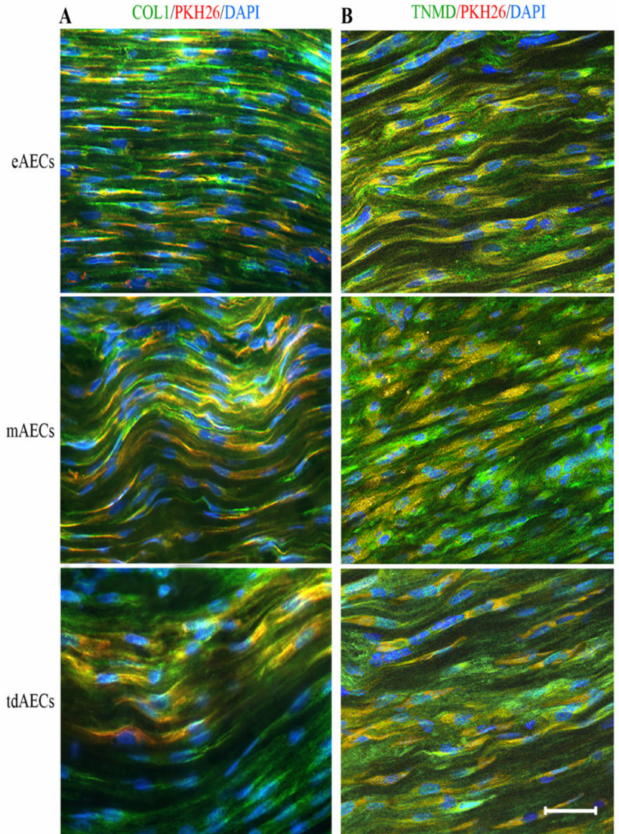
Figure 9. eAECs, mAECs, and tdAECs survived within the host tissue and differentiated into tenocytes. ( A ) Representative images captured at day 14 showing several PKH26-positive cells (red fluorescence) that co-localize with COL1 (green fluorescence), giving a yellow merged fluorescence. These AECs showed a fusiform shape and flattened nuclei (DAPI counterstaining). ( B ) Representative images obtained from samples at day 14 showing several PKH26-positive cells (red fluorescence) that co-localize with TNMD (green fluorescence), giving a yellow merged fluorescence. All three types of co-localizing AECs showed a fusiform shape and flattened nuclei (DAPI counterstaining). Scale bar = 50 µ